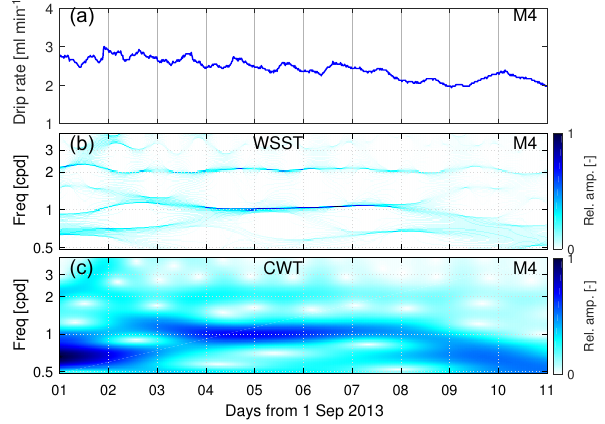
Figure 2. Comparing the time–frequency content of the drip dis- charge rate (a) for drip site M4 (refer to Fig. 3): relative component amplitudes calculated from (b) the wavelet synchrosqueezed trans- form (WSST) and (c) the continuous wavelet transform (CWT) us- ing a Morlet mother